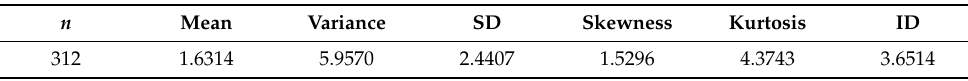
Figure 1. The number of daily new deaths in Luxembourg for 2020. Table 4. Descriptive statistics.